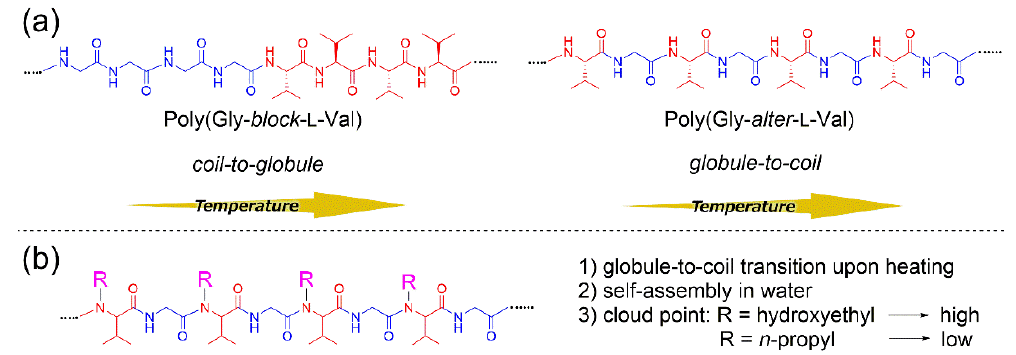
Figure 1. ( a ) Thermo-responsiveness of poly(Gly– block –L-Val) as a diblock copolypeptide and poly(Gly– alter –L-Val) as an alternating peptide (previous work) and ( b ) self-assembly and thermo- responsive properties of alternating peptides (current